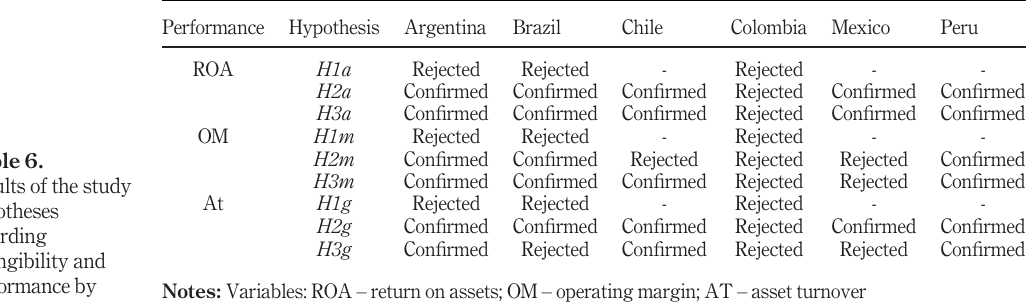
Table 6. Results of the study